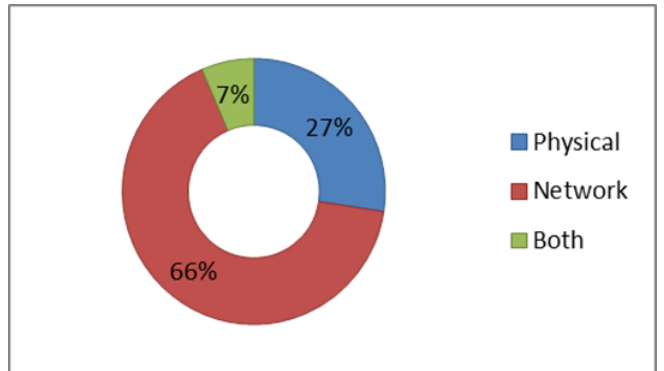
Figure 3. Types of access .